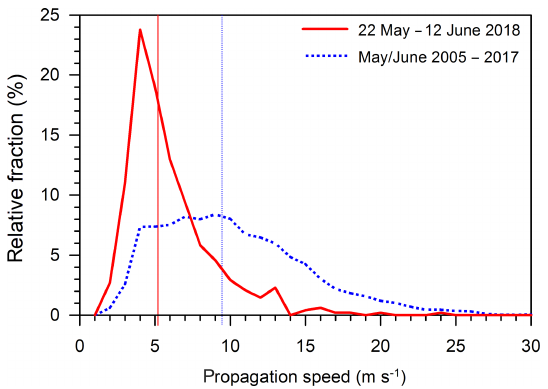
Figure 4. Histogram of the propagation speed of convective cells (increments of 1ms − 1 ) detected by TRACE3D in Germany during the study period (red) and for all convective cells between 2005 and 2017 (May–June; blue); vertical lines indicate the median of the two samples.